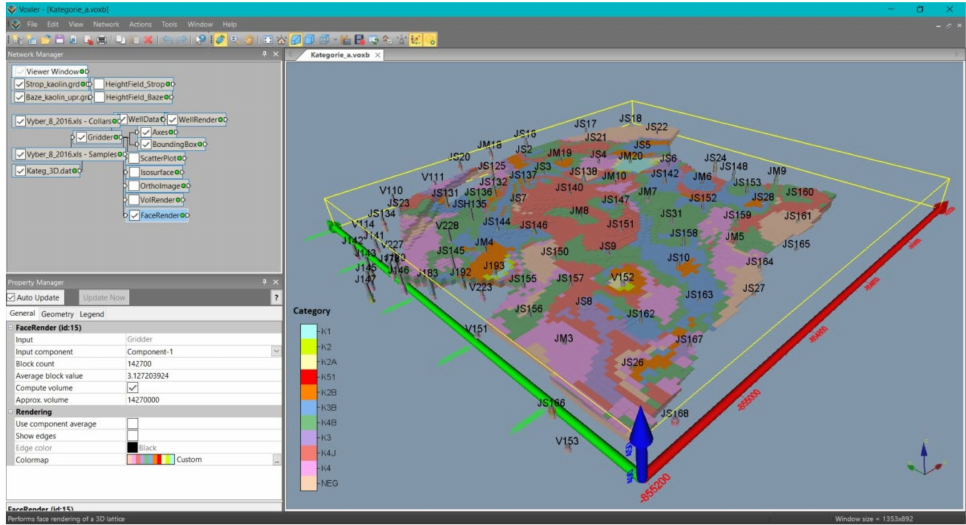
Figure 22. Three-dimensional visualization of categories of blocks of reserves